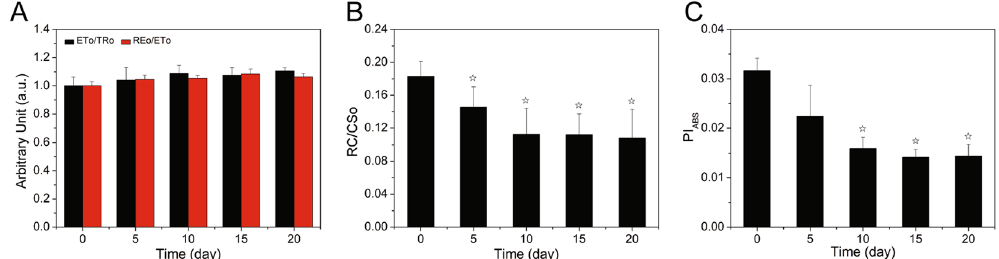
Figure 7. Photosynthetic parameters of nitrogen-starved fluorescence transients analyzed by the JIP test. ( A ) electron transport probabilities: ETo/TRo is the probability that a trapped exciton moves an electron into the electron transport chain beyond QA − , and REo/ETo is the probability that the intersystem electron carriers move to reduce the terminal electron acceptors at the PSI side. ( B ) density of active RCs of PSII per excited CS (RC/CSo). ( C ) summary of all partial forces represented by the single parameter performance index (PI). ( ☆ = P < 0.05 vs. control).